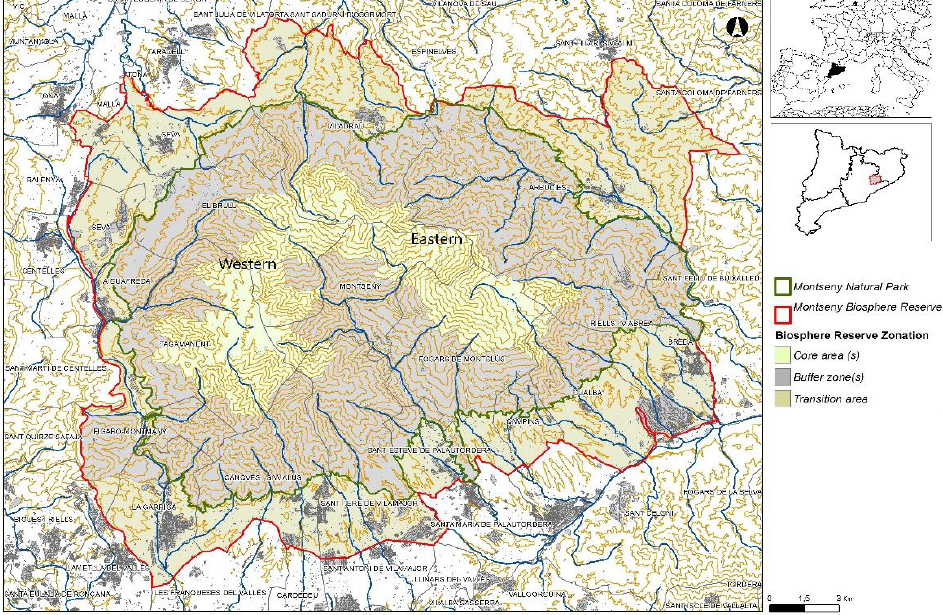
Figure 1. Location of the PNMRB and the two isolated subpopulations (Western and Eastern) of C. arnoldi in La Tordera river basin.